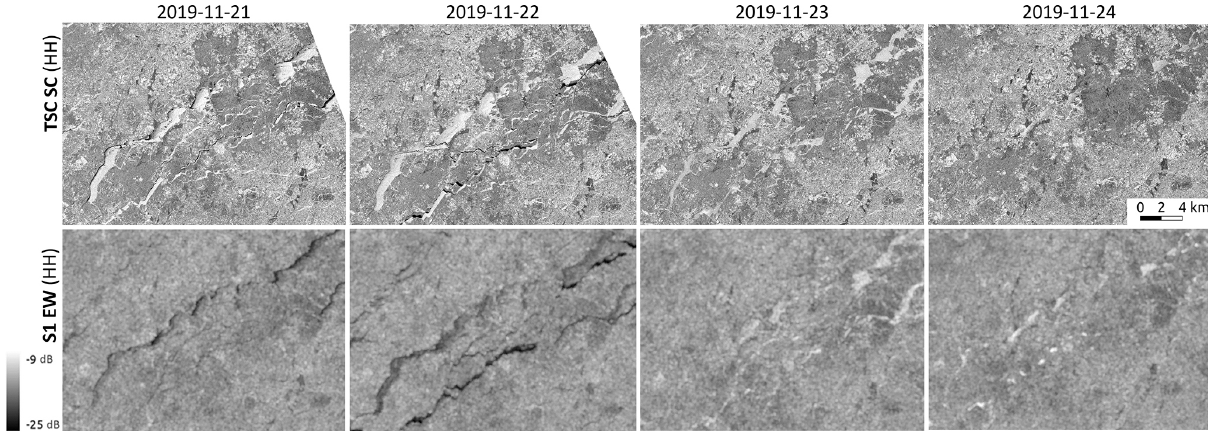
Figure 2. Progression of young ice on near-coincident TSX SC and S1 EW scenes scaled by the same range of intensities. All subsequent figures of HH intensities use the decibel range shown here.